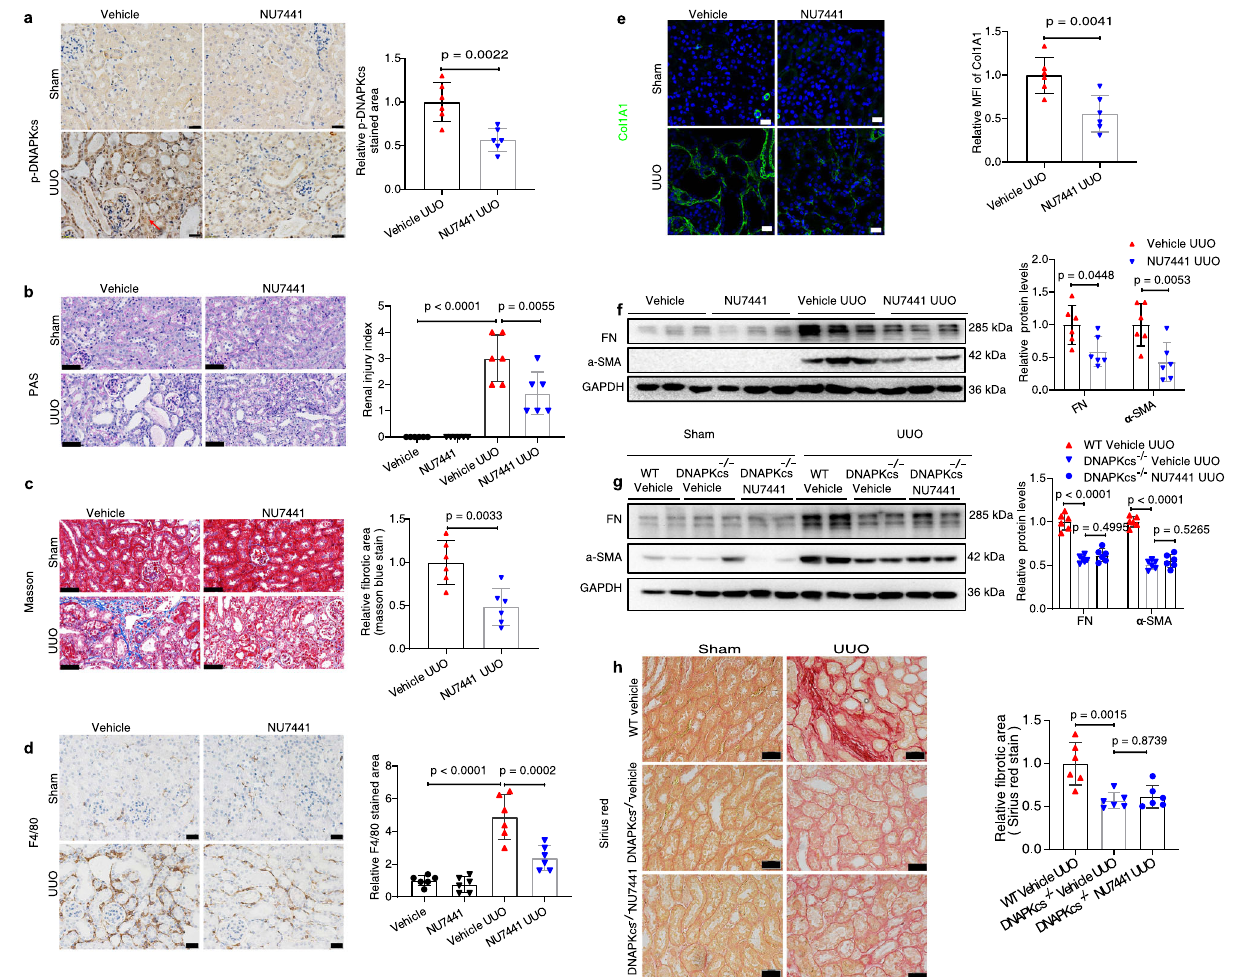
Fig. 3 | Inhibition of DNA-PKcs activity attenuates the development of CKD in UUO mice. a Immunohistochemical staining of p-DNA-PKcs in kidneys of mice treated with NU7441 (40mg/kg) or vehicle subjected to UUO (day 7), scale bars: 20 μ m.Barsrepresentquanti fi cationresults(mean±SD, n =6miceofeachgroup). b PASstainingofkidneysofmicetreatedwithNU7441orvehiclesubjectedtoUUO, scale bars: 50 μ m. Bars represent quanti fi cation results (mean±SD, n =6 mice of each group). c Masson staining of kidneys of mice treated with NU7441 or vehicle subjected to UUO, scale bars: 50 μ m. Bars represent quanti fi cation results (mean±SD, n =6miceofeachgroup). d ImmunohistochemicalstainingofF4/80in kidneys of mice treated with NU7441 or vehicle subjected to UUO, scale bars: 20 μ m.Barsrepresentquanti fi cationresults(mean±SD, n =6miceofeachgroup). e Immuno fl uorescence staining of COL1A1 in kidneys of mice treated with NU7441 or vehicle subjected to UUO, scale bars: 20 μ m. Bars represent quanti fi cation